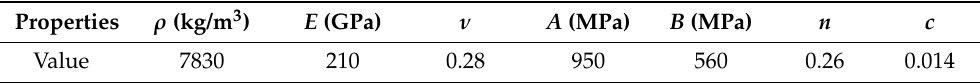
Table 4. Material properties of simplified Johnson – Cook constitutive model.